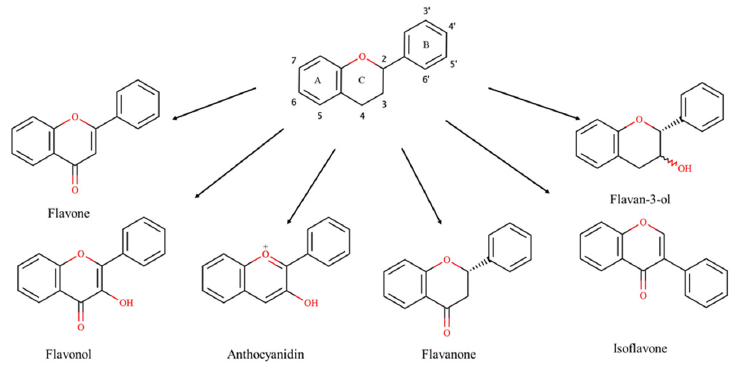
Figure 1. Chemical structures of